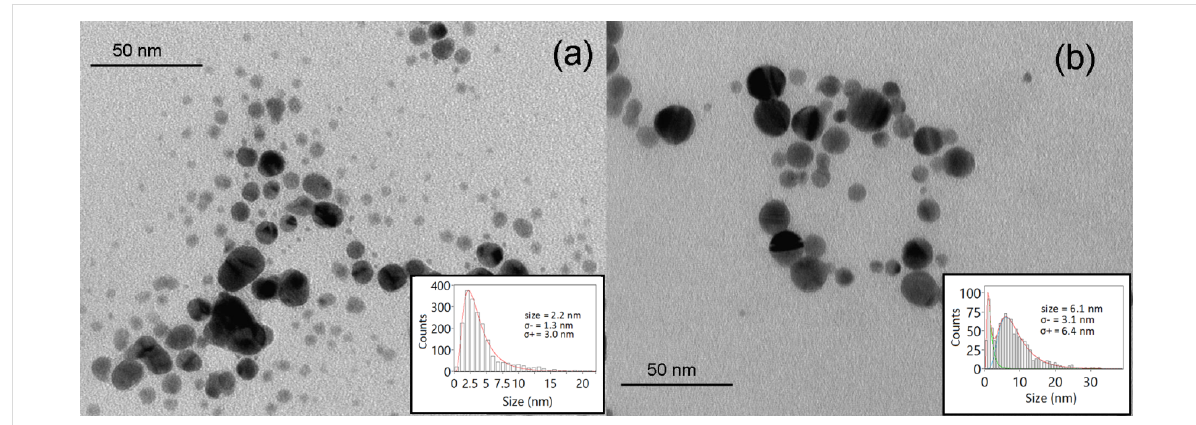
Figure 3: Typical TEM image and size (average diameter) distribution of (a) AgNPsH 2 Ons and (b)